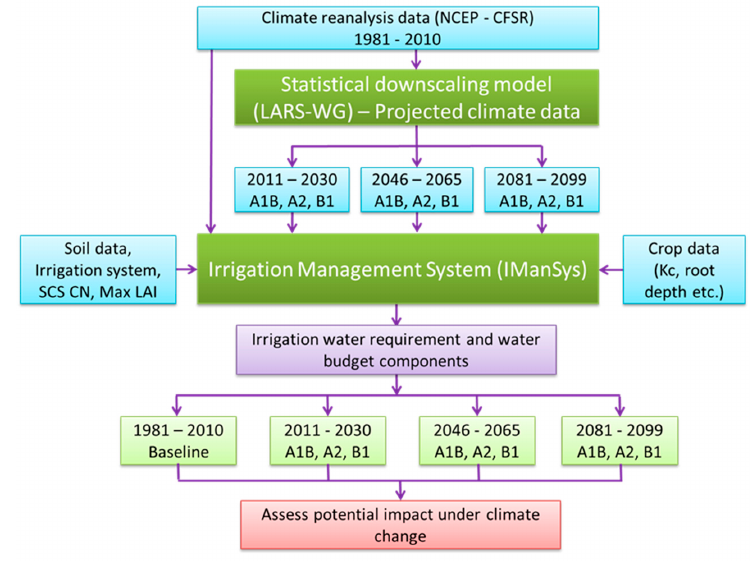
Figure 3. Framework for assessing the potential climate change impacts on irrigation requirements of crops.